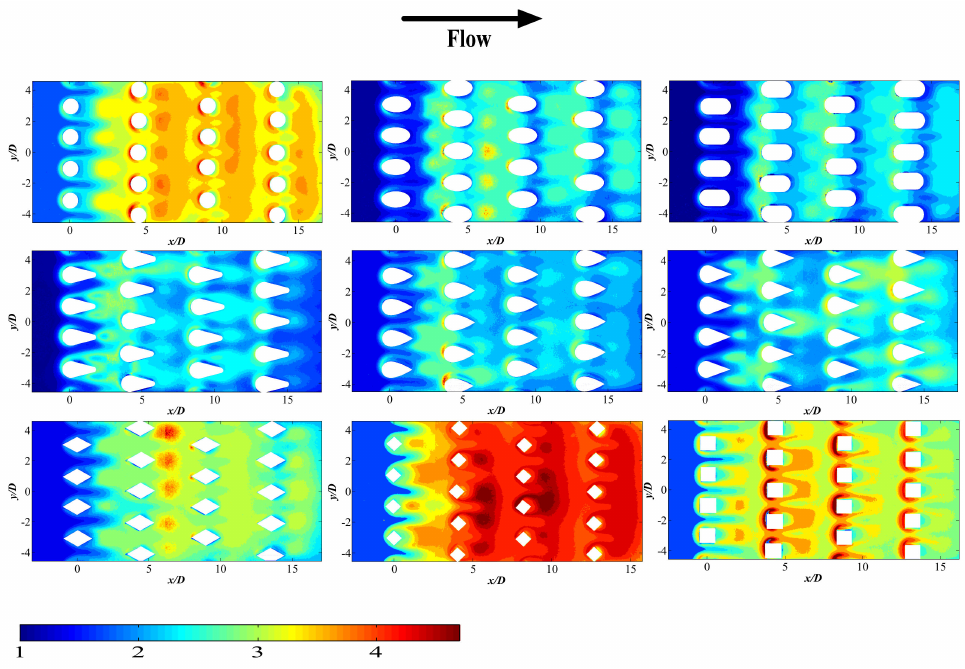
Figure 6. Local distribution of Nu / Nu 0 on endwall with nine different pin fins, Re = 10,000. The Nu distributions for Circle, Ellipse and Oblong are similar, but Circle has the best heat transfer. The high Nu regions downstream the first row are closer to the second row for Ellipse and Oblong compared to those for Circle pins. This means that the flow is not well developed before encountering pin fins in the second row and being constrained. Ellipse and Oblong need a larger streamwise pitch to obtain a better heat transfer performance. The distributions of the three streamline shape pin fins are similar and relatively uniform. The is weaker. However, the Nu of Lancet is a little higher than the other